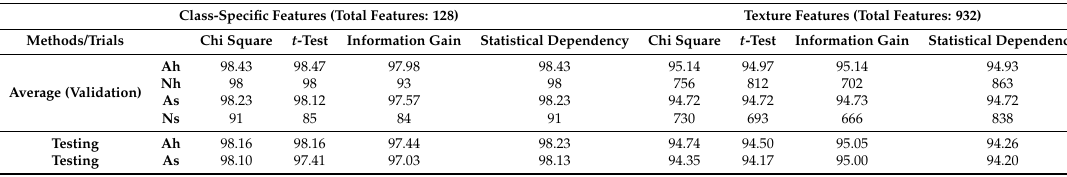
Table 2. Filter methods: Experimental protocol